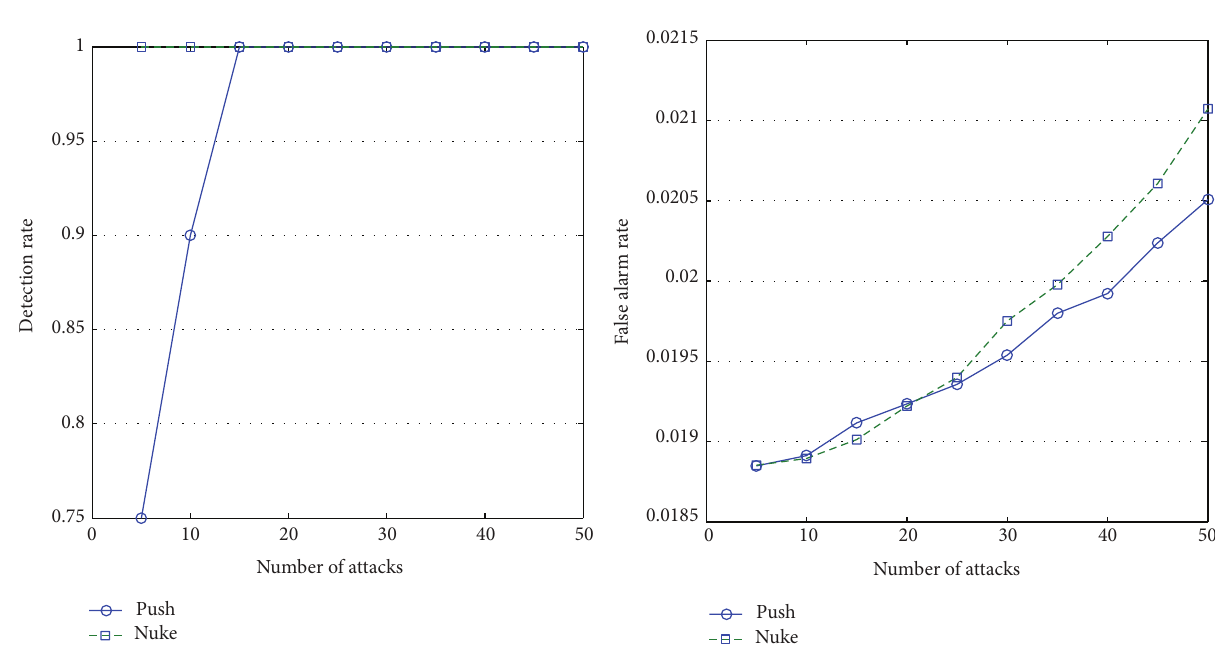
Figure 5: Detection rates and false alarm rates of fashion